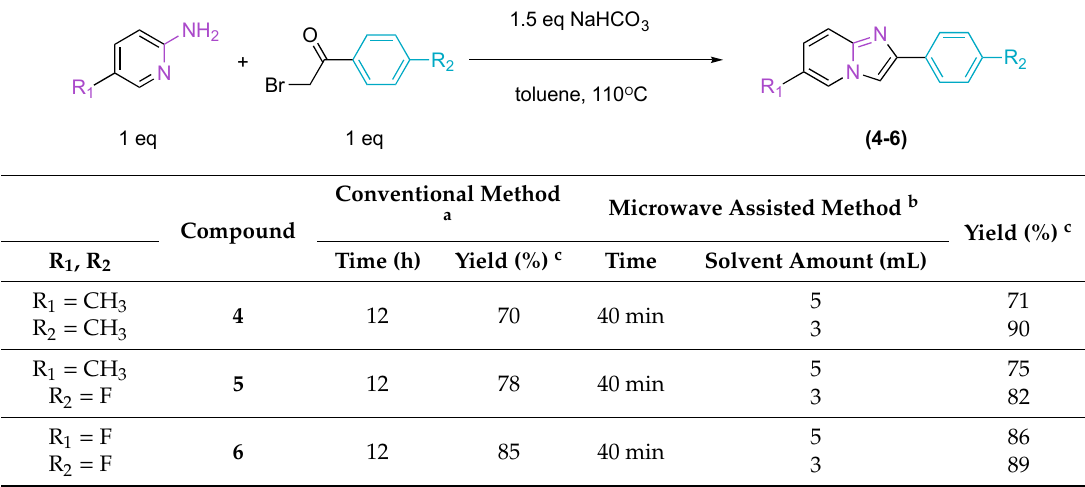
Table 2. Comparison of the performance of condensations between 2-aminopyridines and α -bromoacetophenones under microwave radiation versus traditional oil-bath heating (Step 1).